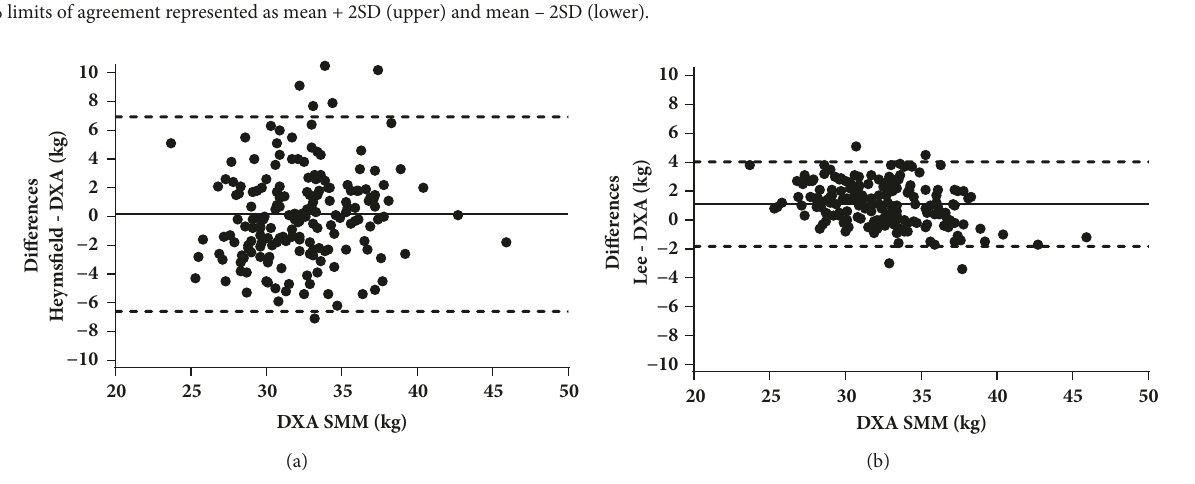
Figure 1: Bland-Altman plots for Heymsfield (a) and Lee (b) equations compared with DXA. Solid line represents mean differences; dashed lines represent 95% confidence intervals (mean ± 2SD). One value is hidden on (a) plot (x = 35.3; y = 14) because of scale adjustment. DXA: dual energy x-ray absorptiometry; SMM: skeletal muscle